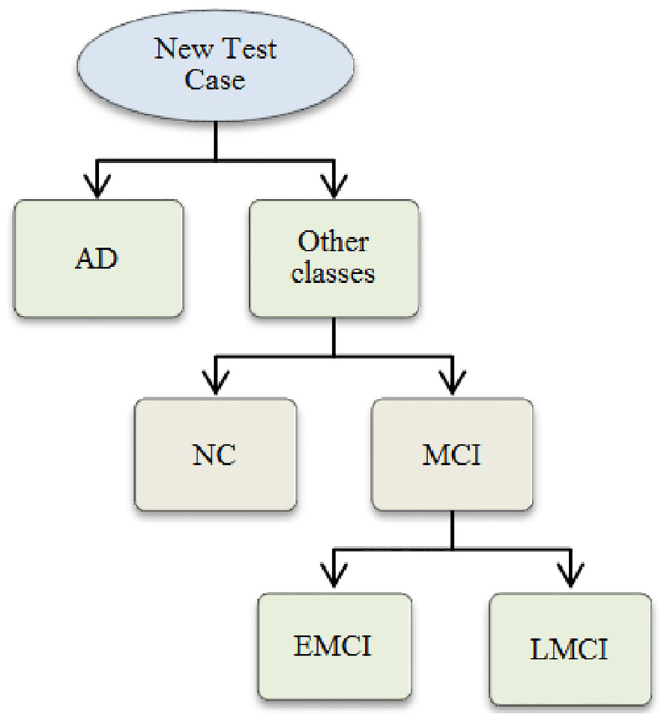
Fig 3. Hierarchical classification scheme to identify the stage of Alzheimer’s disease into NC, EMCI, LMCI, and AD.